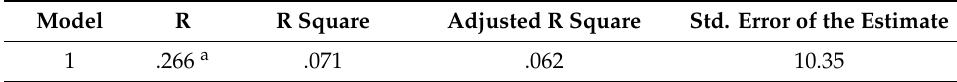
Table 10. Model summary of simple regression analysis.